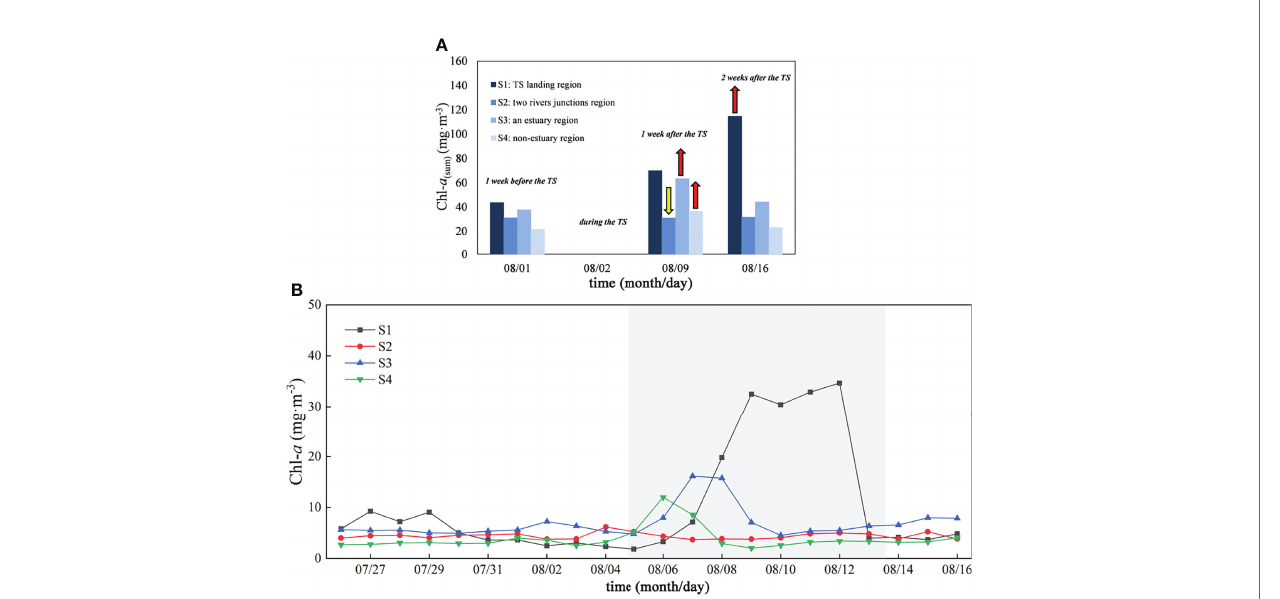
FIGURE 5 | (A) The sum of Chl- a concentration for 7 days for three time periods [1 week before TS (i.e., July 27- August 1), 1 week after TS (i.e., August 3- August 9), 2 weeks after TS, (i.e., August 10- August 16)] at S1-S4. Red arrows represent an increase in the Chl- a (sum) ; yellow arrows represent a decrease in the Chl- a (sum) . (B) Chl- a time series of S1-S4. Gray shading indicates the process from an increase to a decrease in Chl- a at S1, S3, and S4.